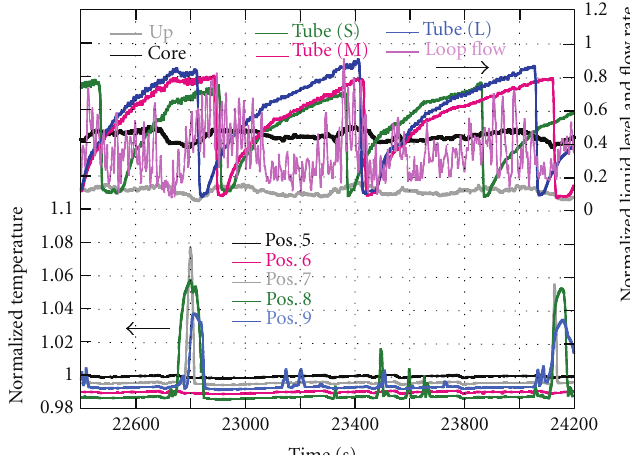
Figure 22: LSTF results for cladding surface temperature, collapsed liquid levels in upper plenum, core, and upflow side of SG U-tubes and primary mass flow rate in loop with PZR (22400 to 24200 s).